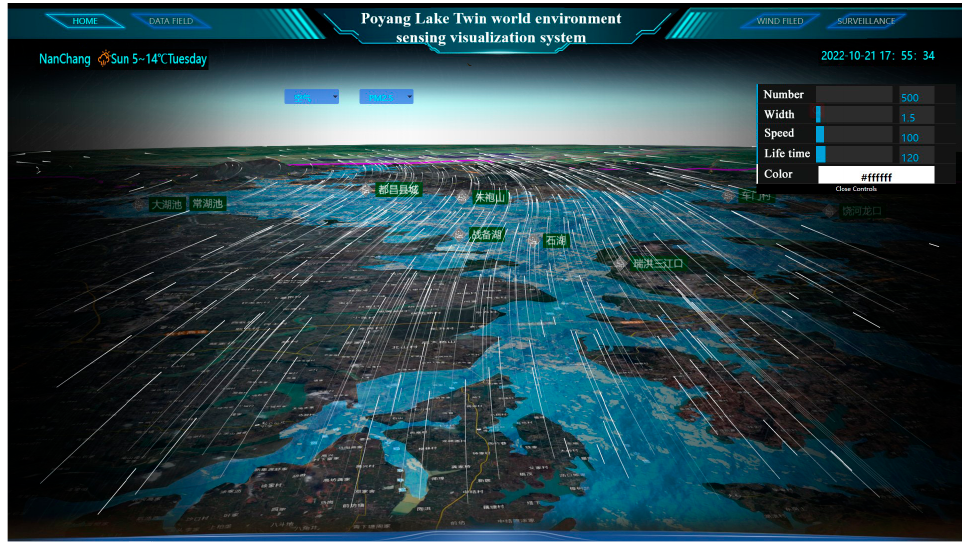
Figure 8. Visualization of the vector field of monitoring